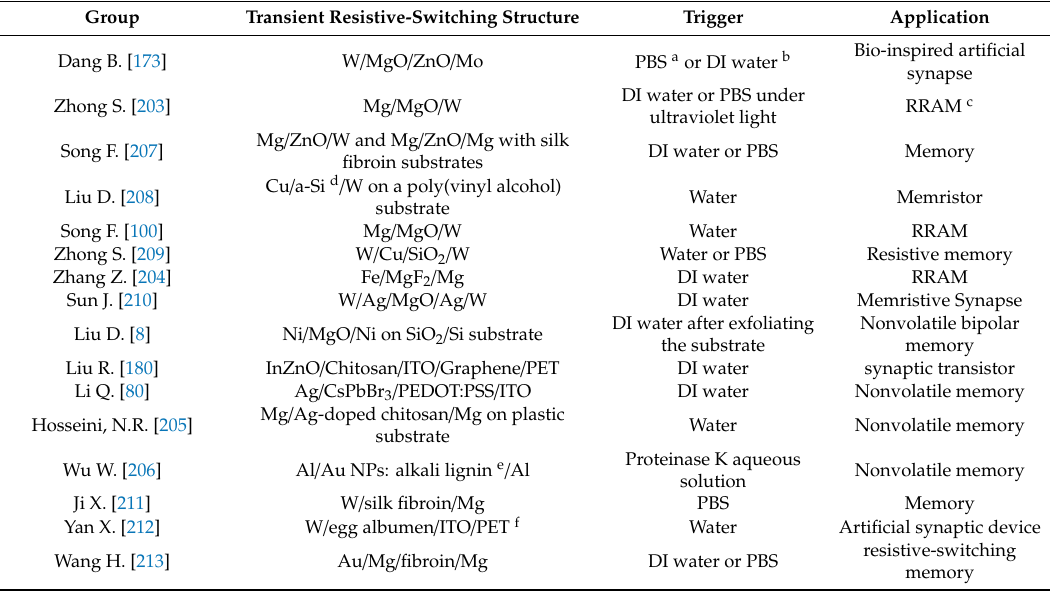
Table 1. Overview of dissolvable resistive-switching